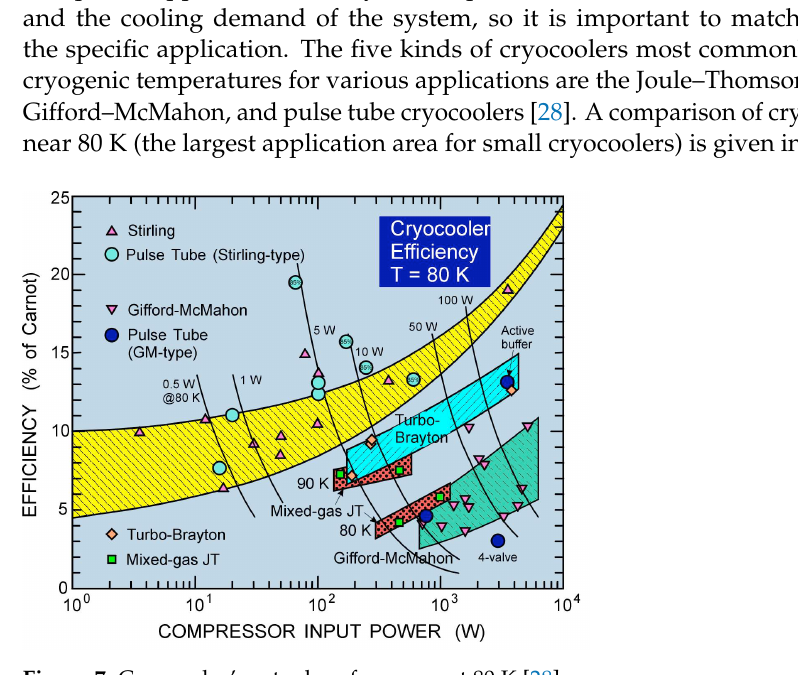
Figure 7. Cryocooler’s actual performance at 80 K